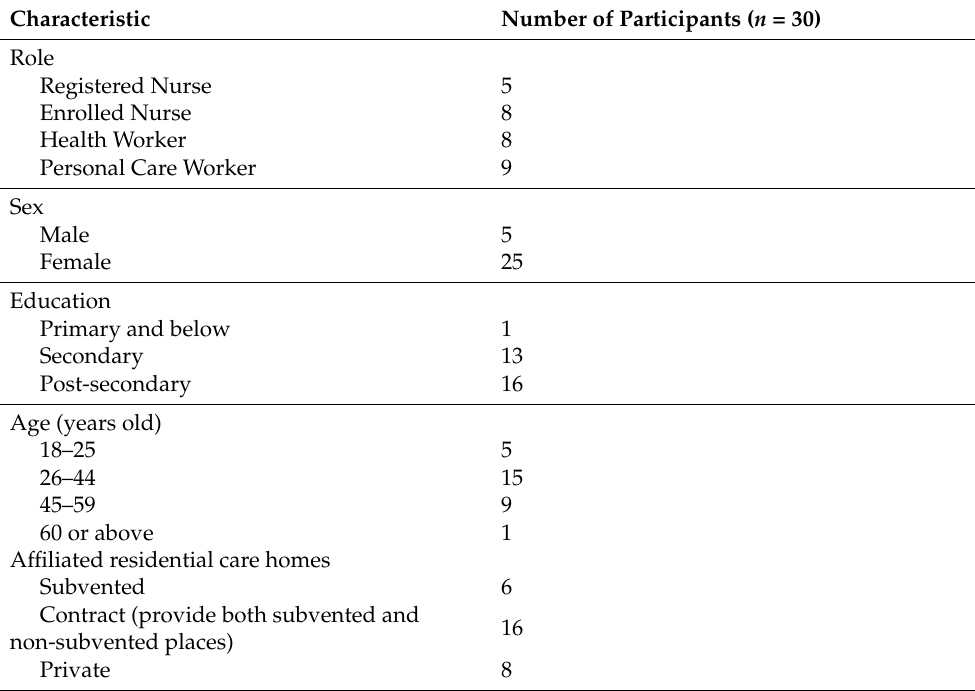
Table 1. Demographic characteristics of participants ( n =